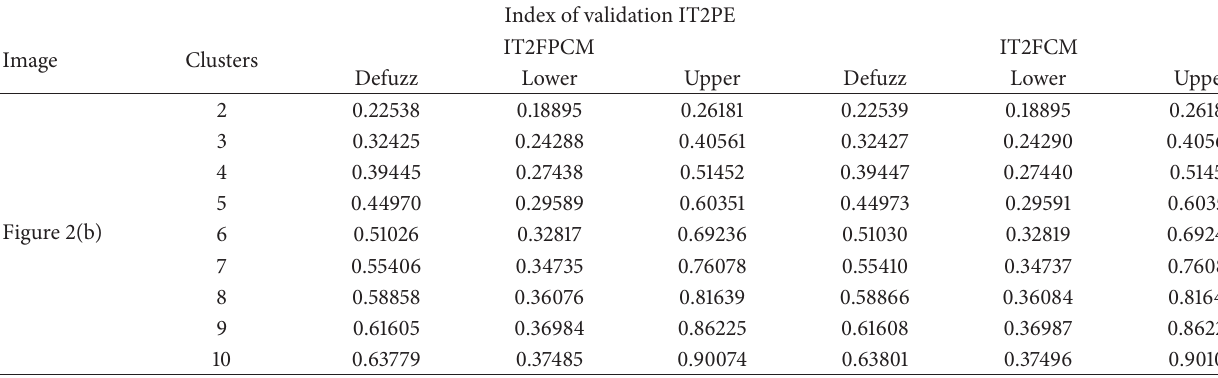
Table 30: Results of the IT2PE validation index to the clustering of image shown in Figure 2(b) using IT2FPCM and IT2FCM algorithm with 𝑚 = [1.5, 2.5] and 𝜂 = [1.5, 2.5] as parameters.